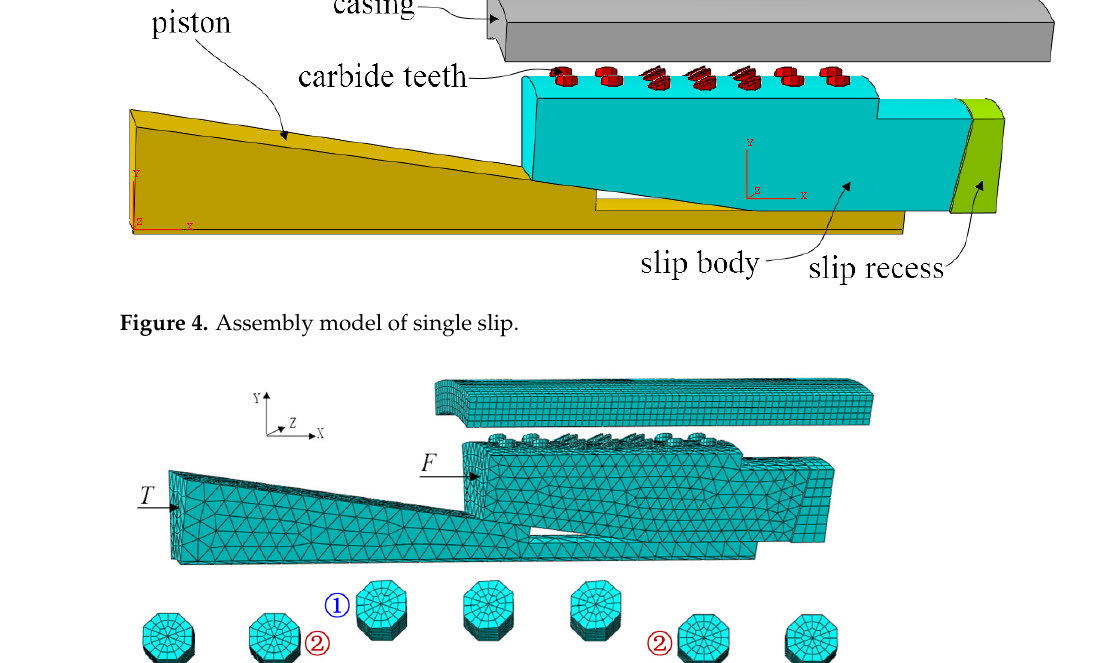
Figure 4. Assembly model of single slip.